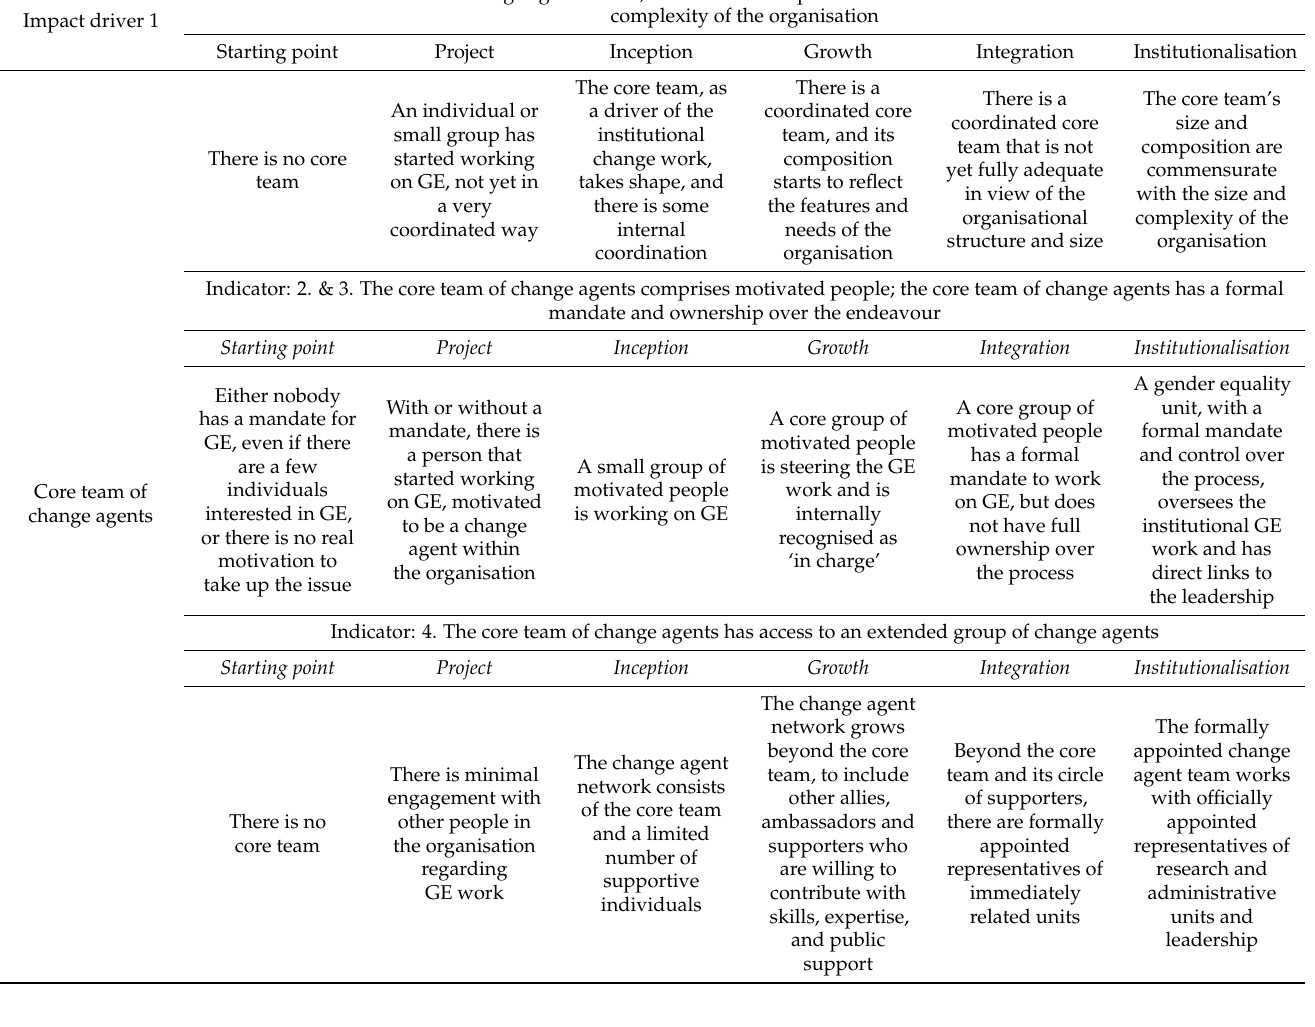
Table 4. Example of an impact driver with indicators and